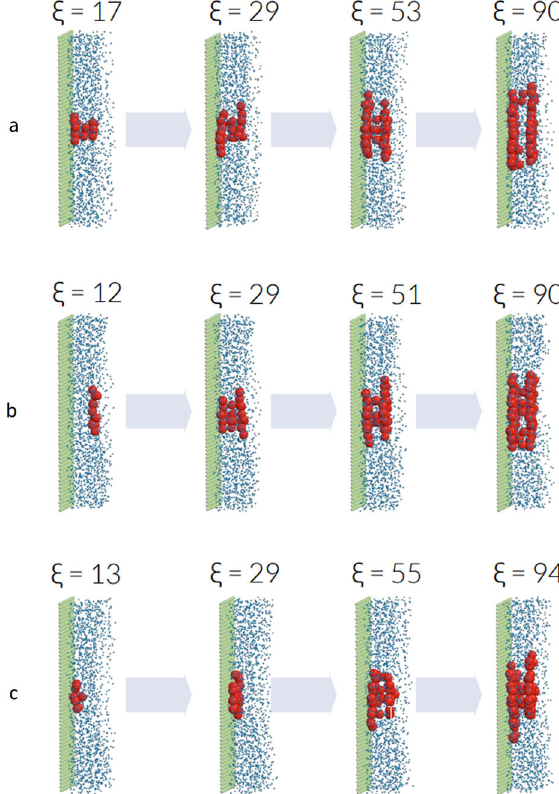
Fig. 1 Nucleation pathways in an ultrathin fi lm of model water at 170 K. Three representative freezing pathways for nuclei that start ( a ) at both interfaces, ( b ) at the free interface only, and ( c ) at the ice nucleating particle (here the graphene support). The ice nucleating particles and water droplets are depicted in dark red and light blue, respectively, on a graphene support (green). The number of molecules within the largest crystalline nucleus is given as the order parameter ξ . Each con fi guration is a progeny of the con fi guration to its left. Reproduced from 1 , copyright (2021) American Chemical